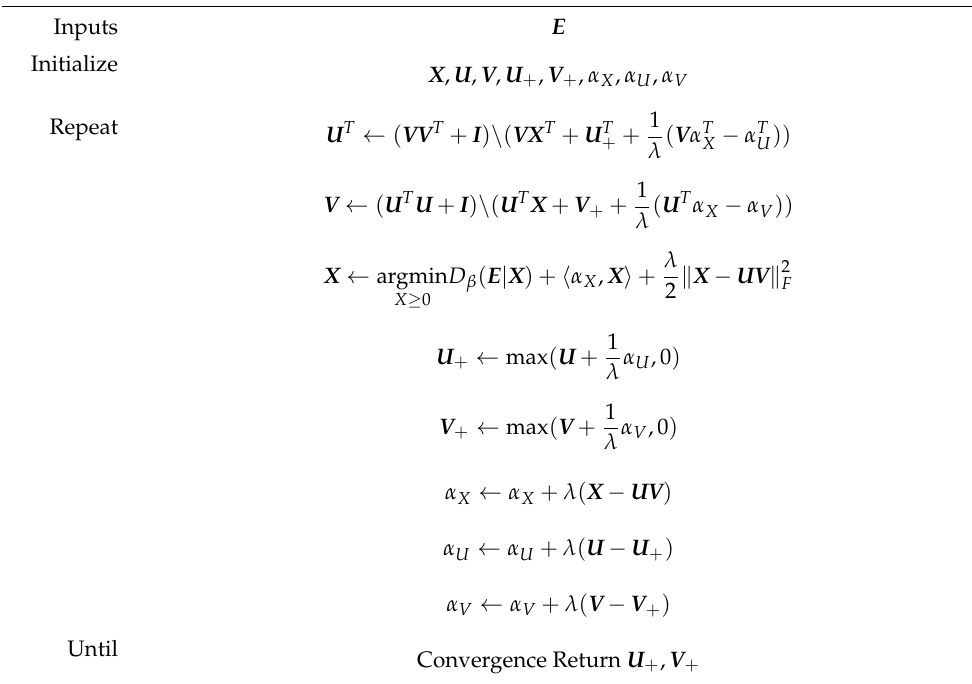
Algorithm 1 The ADMM-based β -divergence